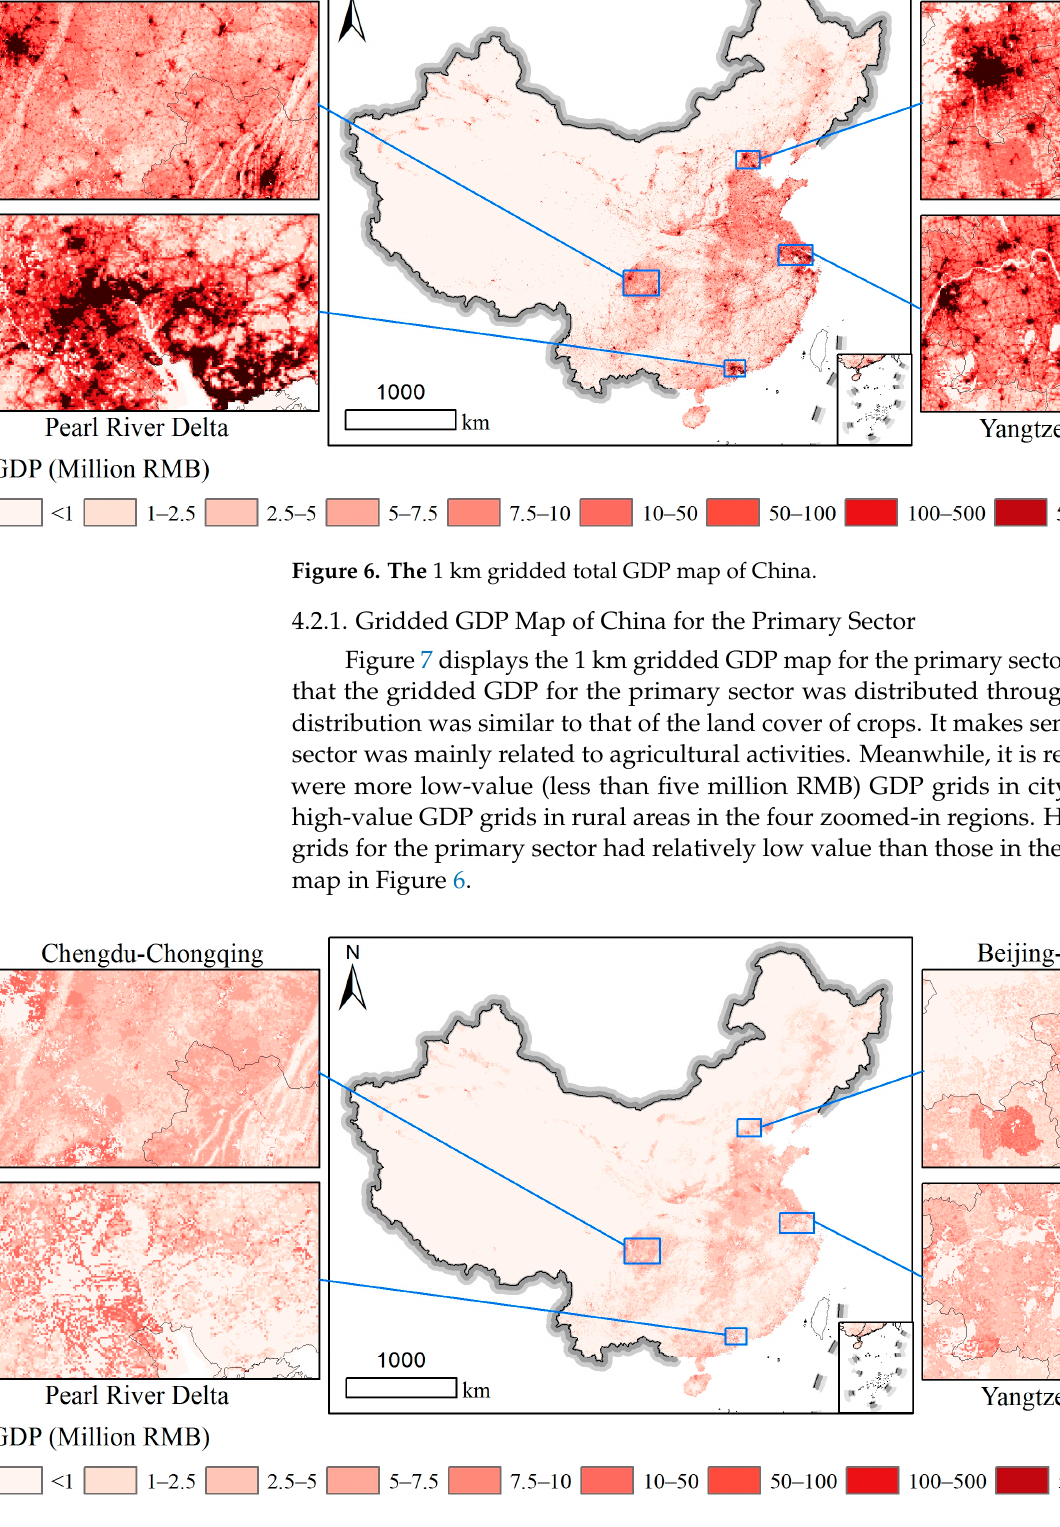
Figure 7. The 1 km gridded GDP map of China for the primary sector.